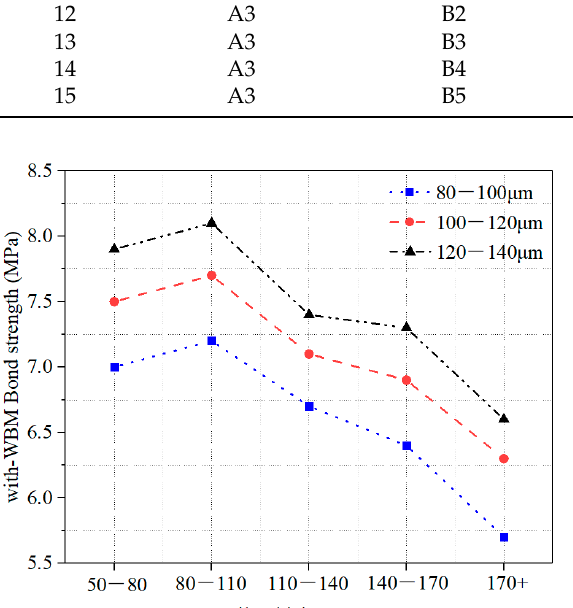
Table 15. Results of two-factor ANOVA of no-WBM bond strength.